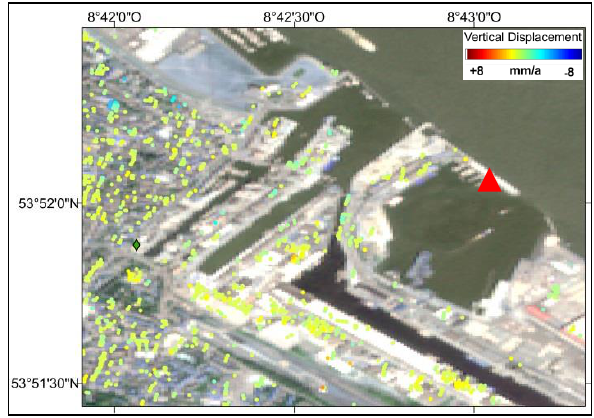
Figure 5: PS results from for Patch 3 at the gauging station Cuxhaven Steubenhöft. Red triangle location of gauging station with equipped GNSS, green diamond location of SAPOS station